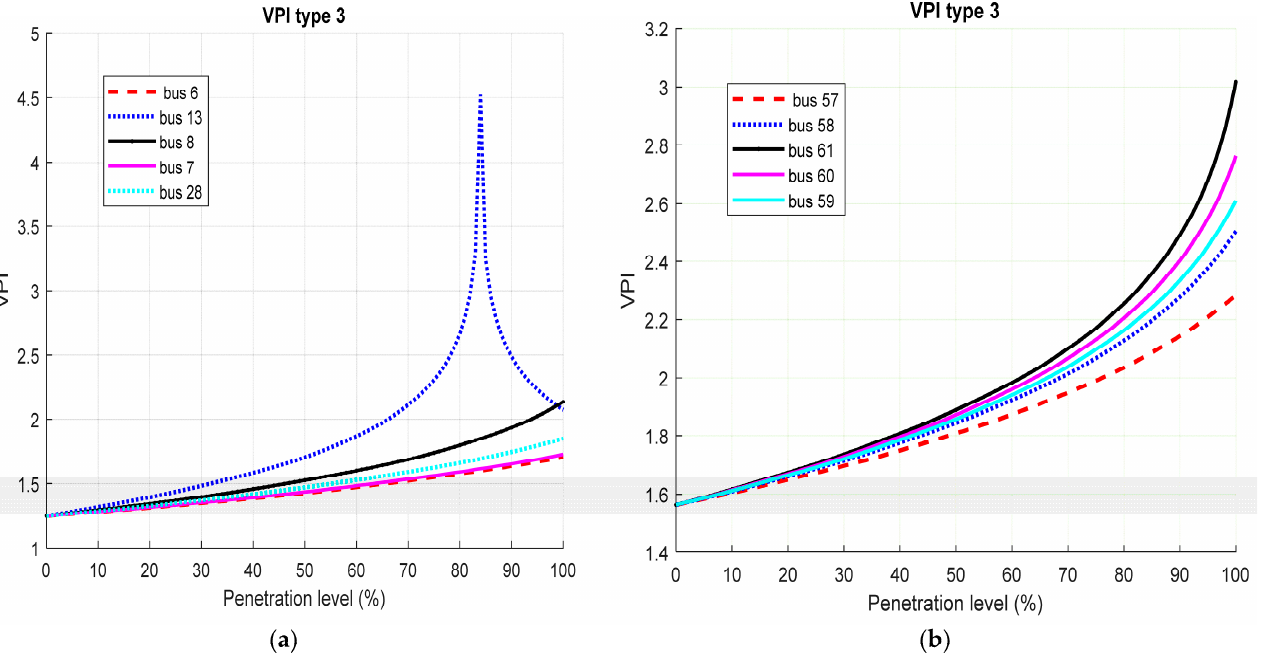
Figure 21. VPI when Type 3 DG was interconnected to the selected nodes of ( a ) 33-bus ( b ) 69-bus RDNs.